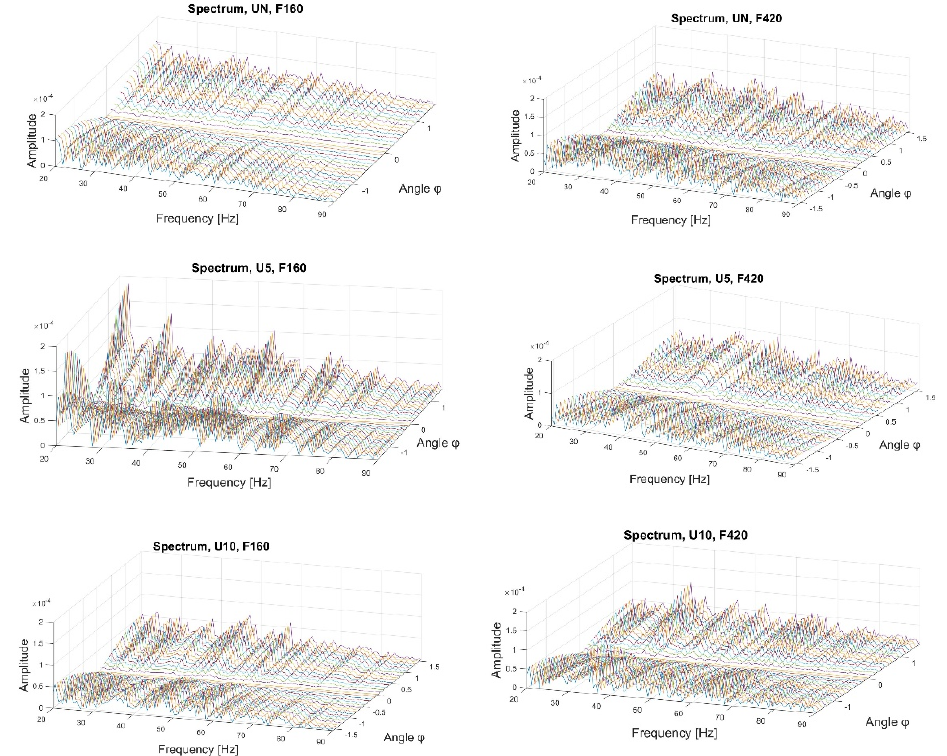
Figure 5. Envelope spectrum of the fractional Hilbert transform.